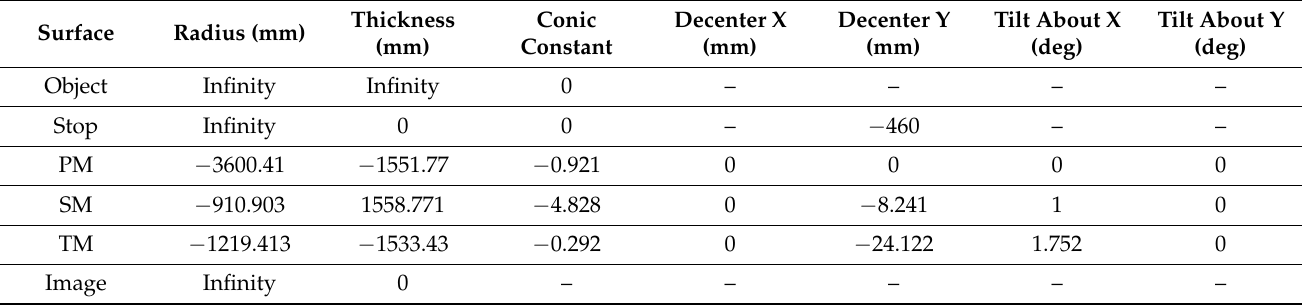
Table A1. Optical structure parameters of the off-axis TMA telescope.